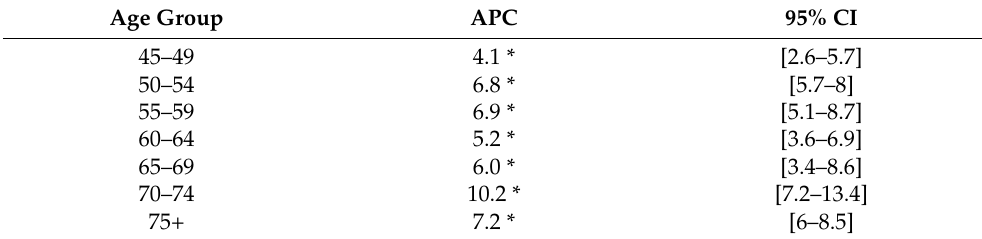
Table 3. Trends in Breast Cancer Incidence by Age Groups (2001–2017).